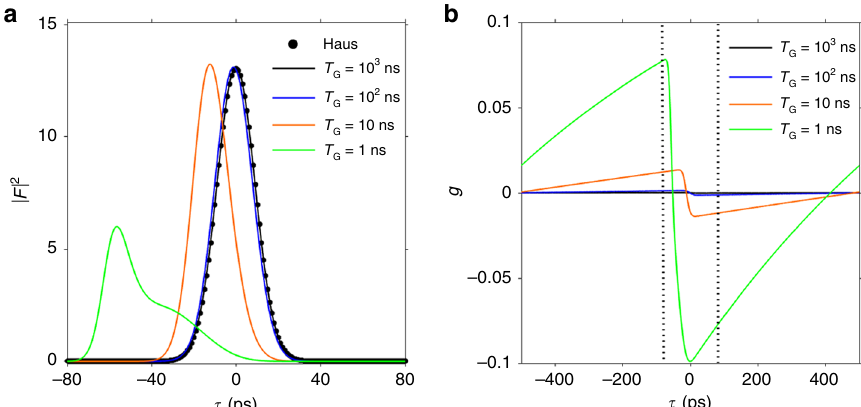
Fig. 1 Dependence of modelocked pulses on the gain recovery time. In ( a ) the pulses calculated from CME (20) for four different values of the gain recovery time T (decreasing from right to left) are shown and compared with that of Haus ME (23). As T G more from the Gaussian centered at τ ¼ 0. In ( b ) the corresponding pro fi le of the fast gain is shown: g increases in magnitude for faster gain media. The vertical dashed black lines denote the time interval shown in ( a ). Parameters used are Ω